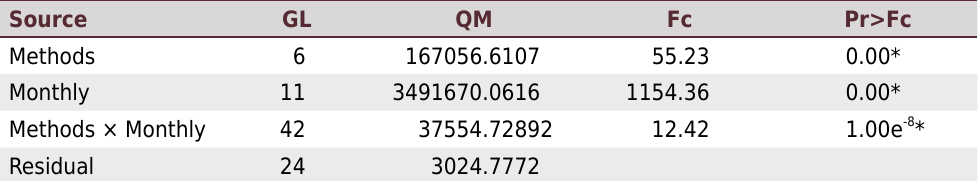
Table 2. Summary of the analysis of variance and mean squares associated with the effect of the interaction between methods and months, referring to the rainfall erosivity of